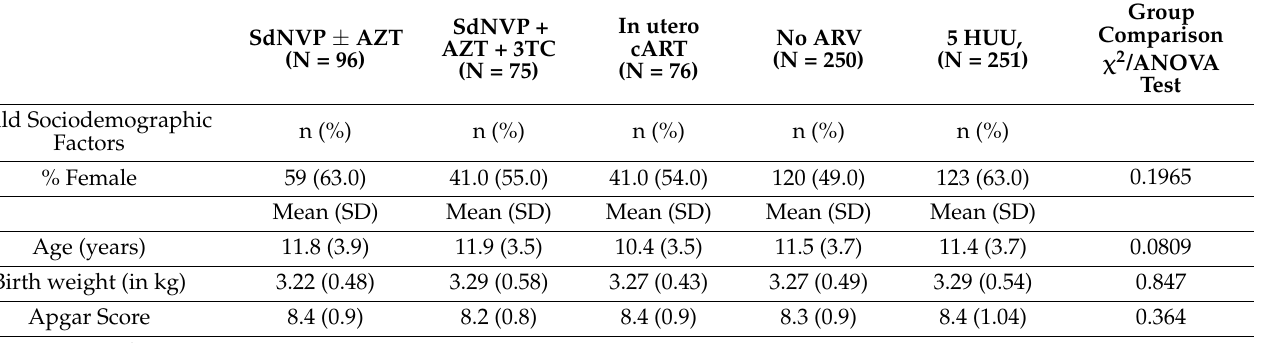
Table 1. Baseline description of children and caregivers in the study base with respect to type of early-life ART